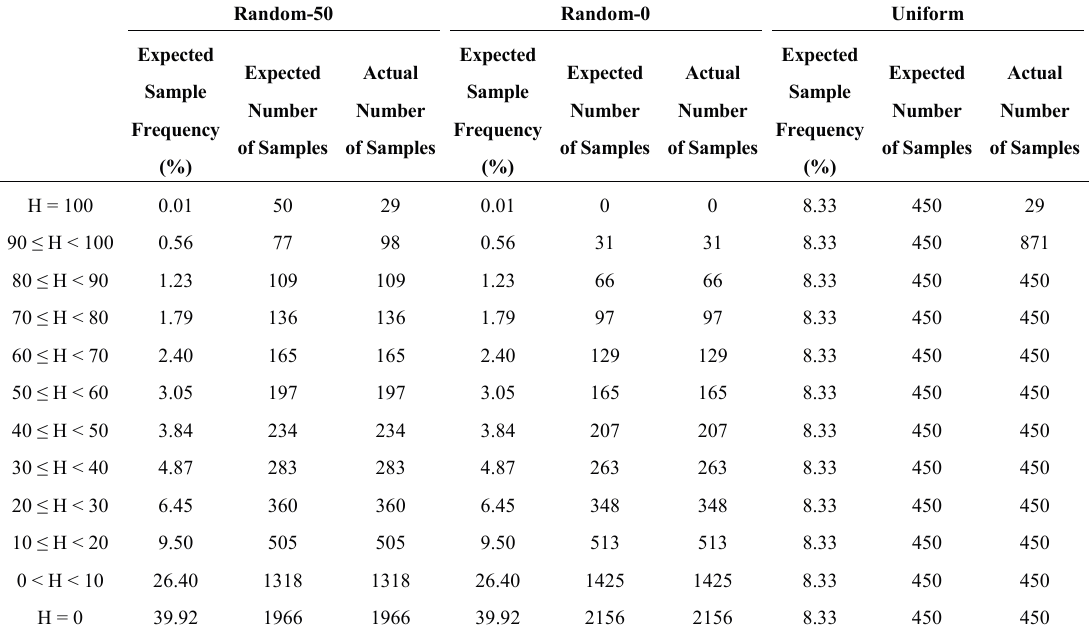
Table 7. Random and uniform allocation of heterogeneous pixels for regression trees for class Evergreen forest. Homogeneity (H) in